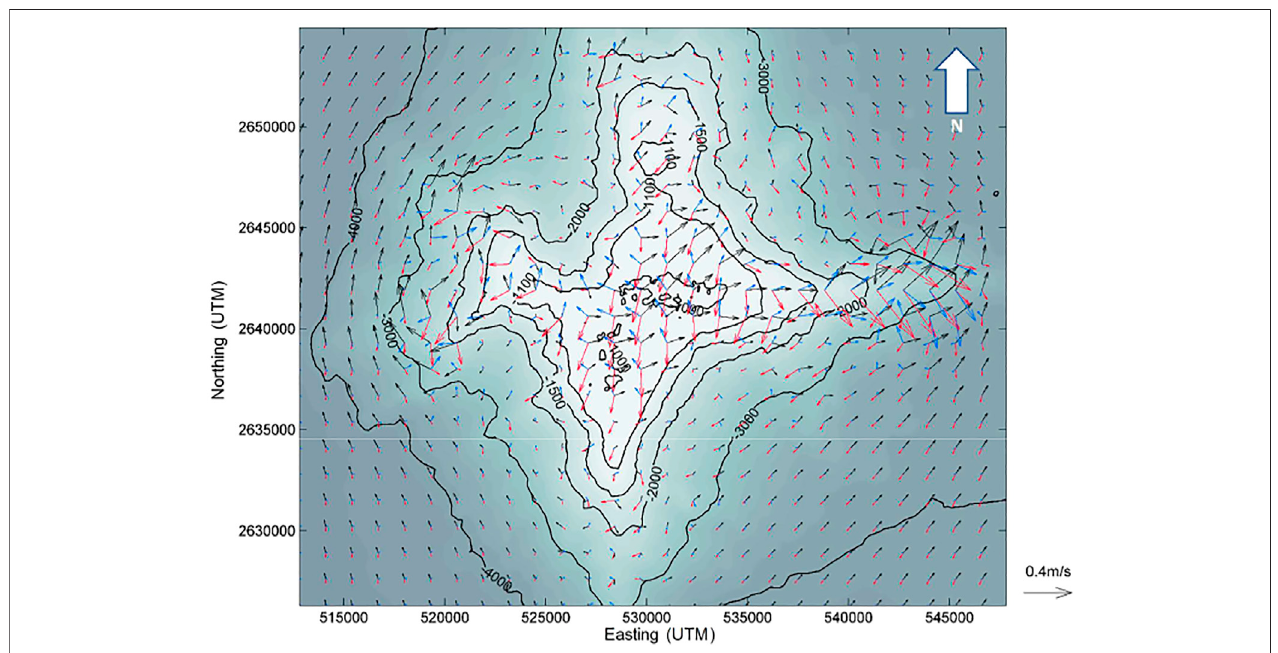
FIGURE 3 | Snapshots of currents 10 m above the bed in the vicinity of the Tropic Seamount, during a spring tide at HW (black), HW+4 h (ref) and HW+8 h (blue) (Spearman et al., 2020).